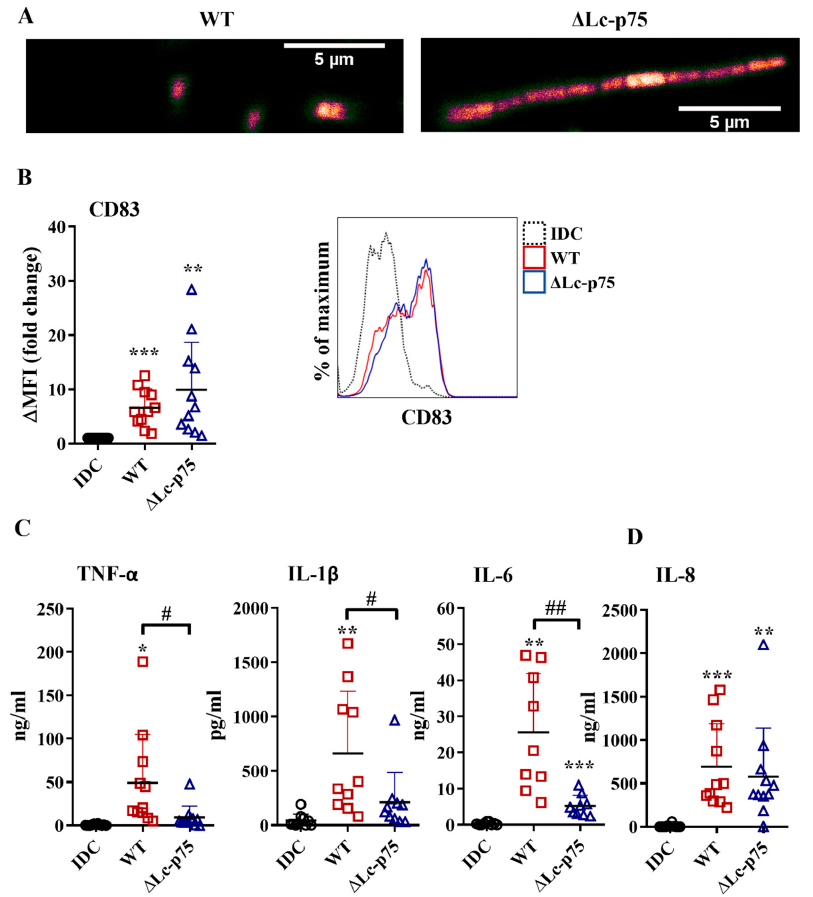
Figure 1. The absence of Lc-p75 PGH affects bacterial morphology and the inflammatory mediators’ production, but not the CD83 expression by bacteria-activated moDCs. ( A ) Confocal microscopic pictures of mCherry-expressing wild-type (WT) and ∆ Lc-p75 L. casei strains. Five-day moDCs were co-incubated with WT and PGH mutant bacteria at a ratio of 1:4 for 24 h. The expression of CD83 ( B ) was measured by flow cytometry. Fold change of median fluorescent intensities ( ∆ MFI) compared to the control, nontreated cells (immature DC/IDC/) was calculated from 6–9 independent experiments ± SD. Histogram overlays show one representative experiment. Each dot is representative of one donor. The concentrations of proinflammatory TNF- α , IL-1 β , and IL-6 cytokines ( C ) and IL-8 chemokine ( D ) were measured using ELISA from the supernatant of activated moDCs and control, nonactivated cells (IDC). Figures show the mean of 9–11 independent experiments ± SD. Statistical analysis was performed using the Student’s paired two-tailed t -test with significance defined as * p < 0.05, ** p < 0.01, and *** p < 0.001 as compared to IDC. The differences between WT and ∆ Lc-p75 were statistically significant and defined as # p < 0.05 and ## p < 0.01. To assess the impact of Lc-p75 inactivation on the inflammatory-provoking capacity of moDCs, we studied the CD83 expression and inflammatory cytokine and chemokine secretion by moDCs treated with WT and Δ Lc-p75 L. casei strains for 24 h at a ratio of 1:4.